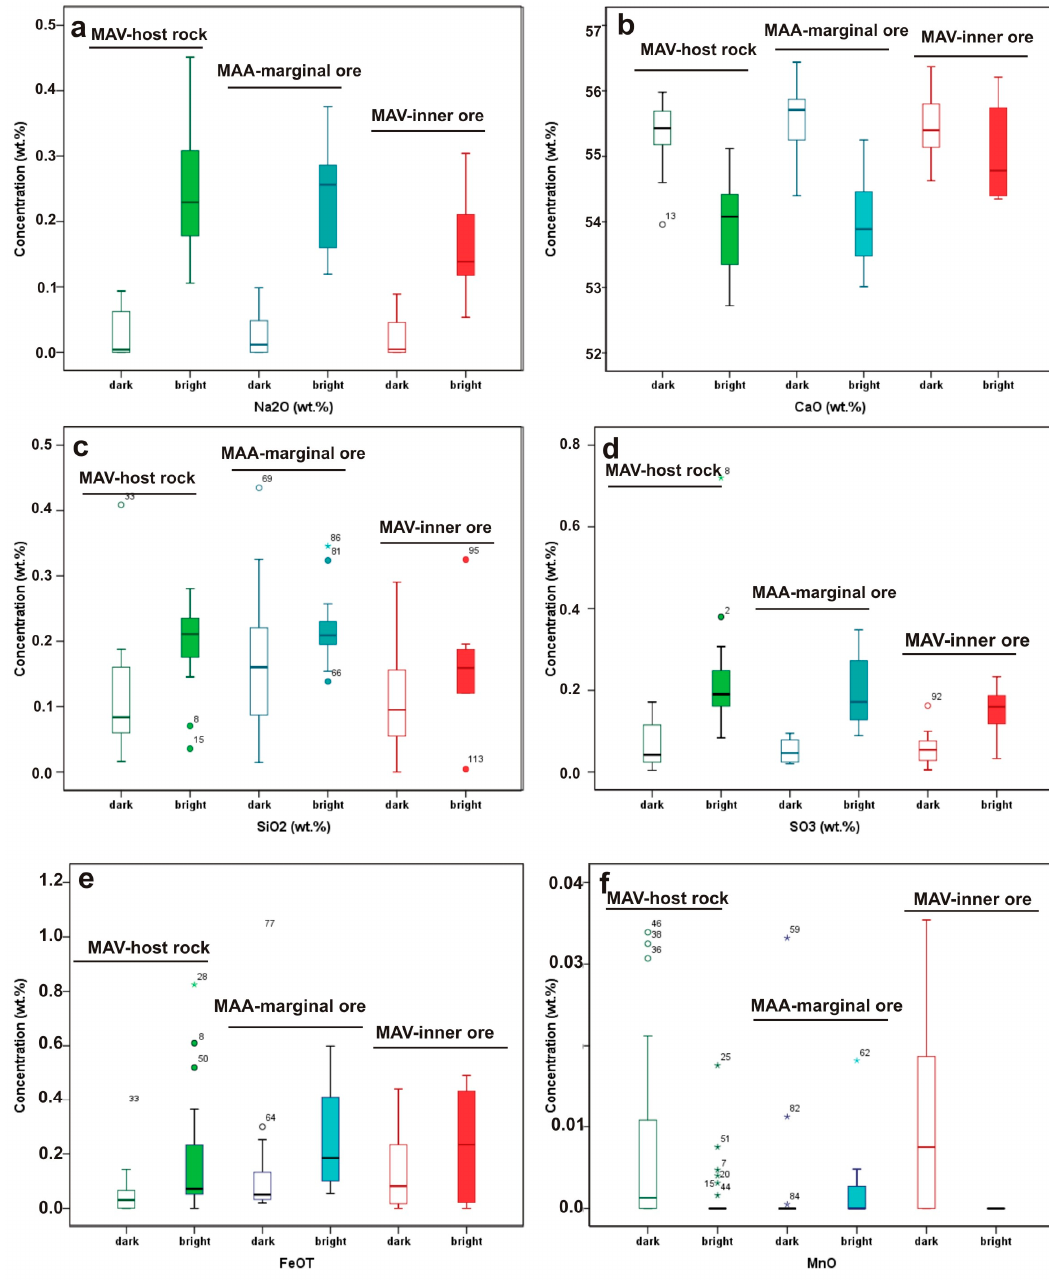
Figure 8. ( a – f ) Comparative box-plots for selected key oxides for various apatite types from the Chadormalu iron deposit.